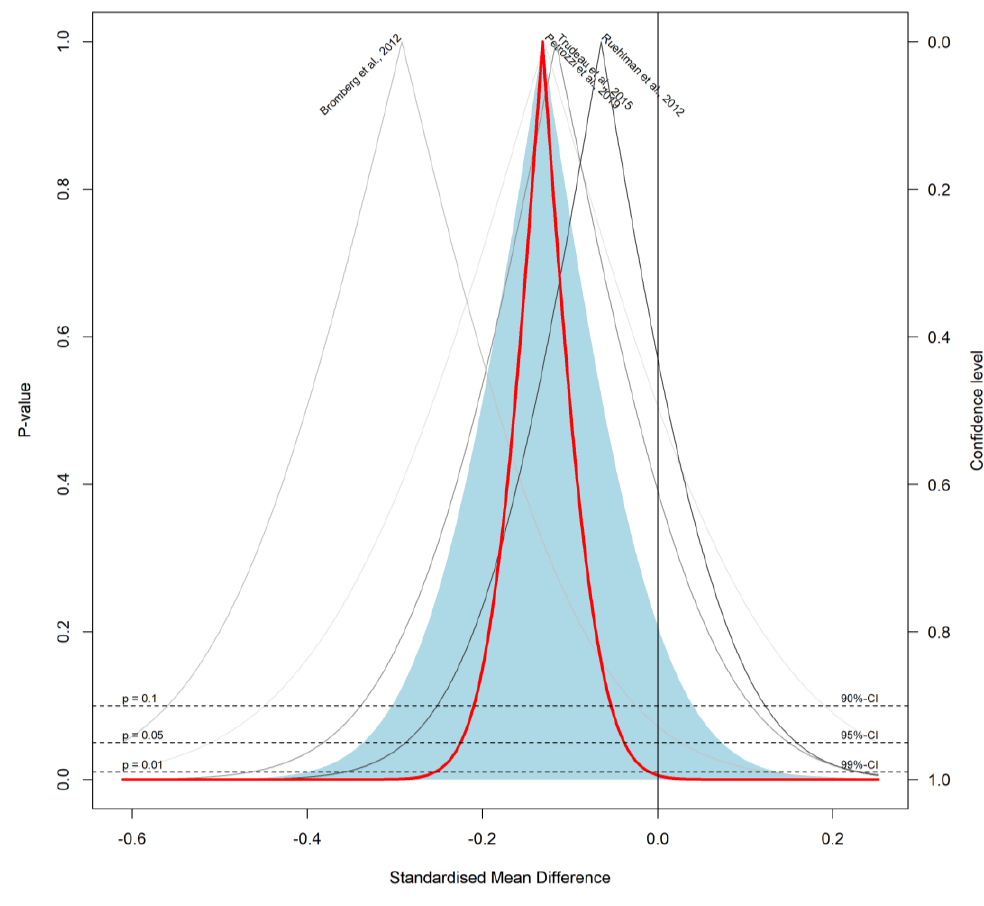
Figure A21. Drapery plot of all the studies.